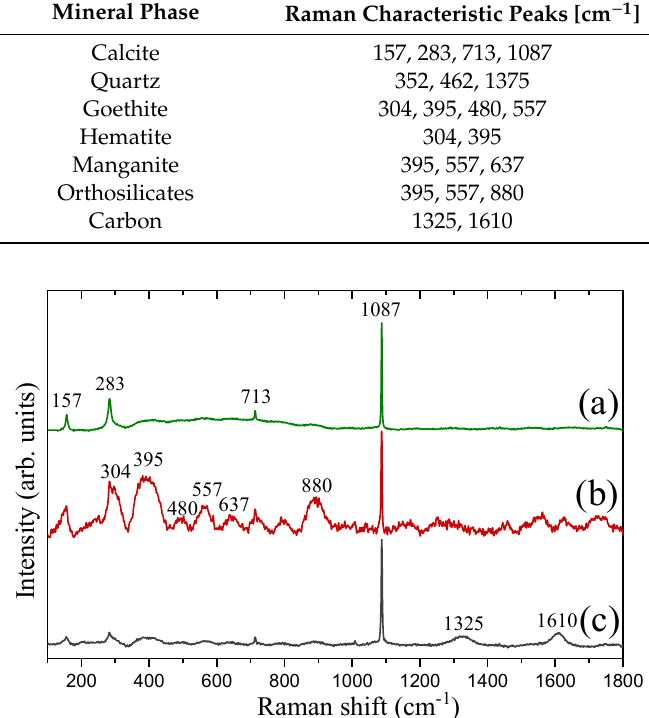
Figure 5. Raman spectra obtained from different points of samples 5(a) and 6(b,c). The Raman wavenumbers of the most intense Raman peaks are indicated. A not‐homogeneous composition in different point of samples 5 and 6 is observed. The tentative assignment of Raman lines is present in